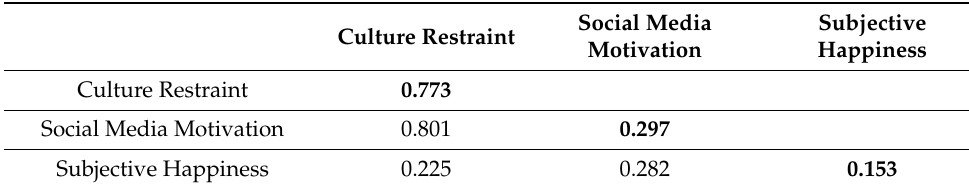
Table 3. Heterotrait–monotrait ratio (HTMT) matrix.